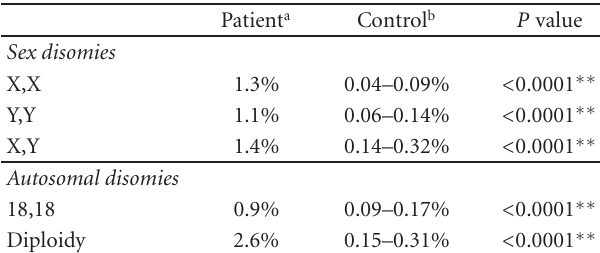
Table 4: Aneuploidy percentages of chromosomes X, Y, and 18 in the heterochromatin polymorphism carrier and in a chromosoma- lly normal control